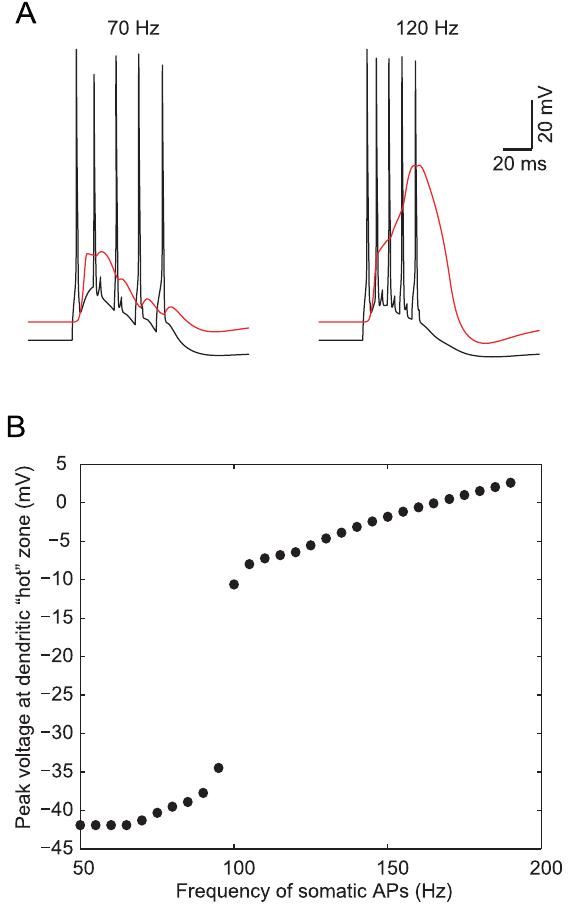
Figure 5. Ca 2 + electrogenesis in distal apical dendrites in response to a critical frequency of somatic stimulation. A. The dually-constrained model neuron shown in Figure 4 was stimulated at the soma with a train of five brief suprathreshold depolarizing pulses, resulting in a train of somatic Na + APs (black). Left, five somatic APs at 70 Hz did not elicit a Ca 2 + spike in the dendrites whereas at 120 Hz (right) a regenerative Ca 2 + spike was generated in the dendrites (red trace denotes dendritic voltage, measured at 830 m m from soma). B. Peak voltage response in the apical dendritic ‘‘hot’’ zone (830 m m from soma) as a function of the frequency of the somatic train of five APs. At a ‘‘critical frequency’’ around 100 Hz an ‘‘all or none’’ Ca 2 + spike was generated at the